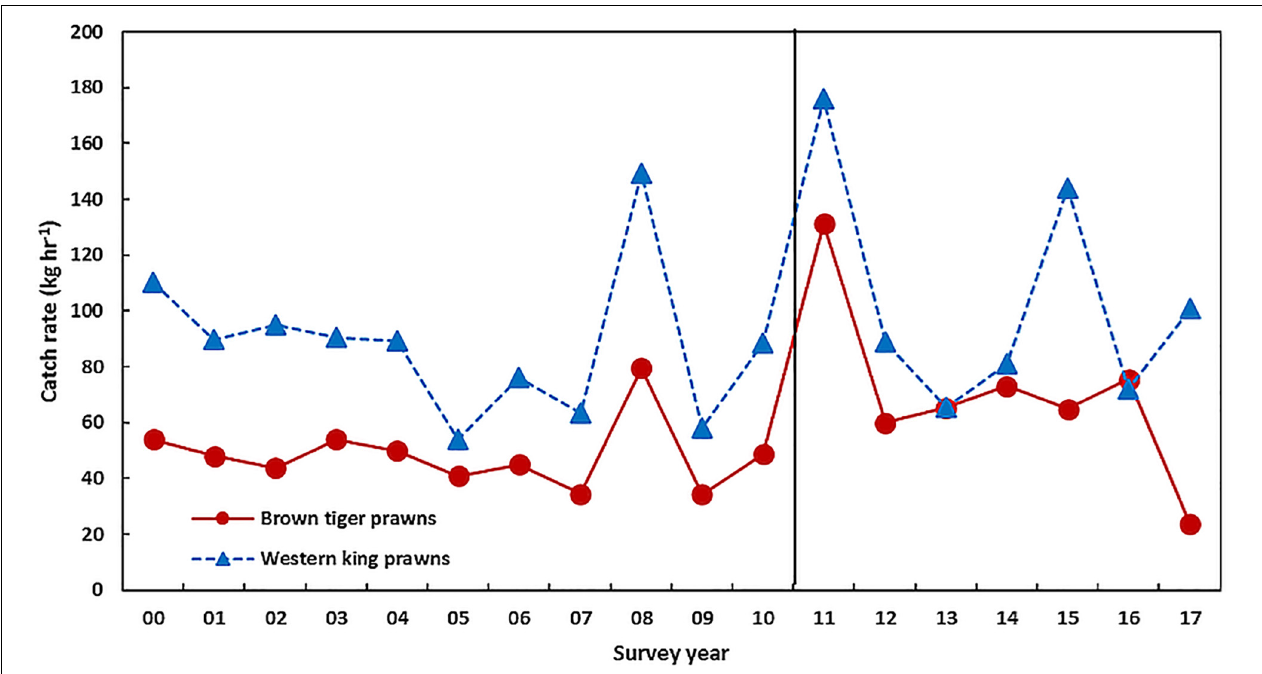
FIGURE 9 | The recruitment abundance (0 +) of brown tiger prawns and western king prawns in Shark Bay from trawl surveys in March–April each year. The vertical line indicates the occurrence of the